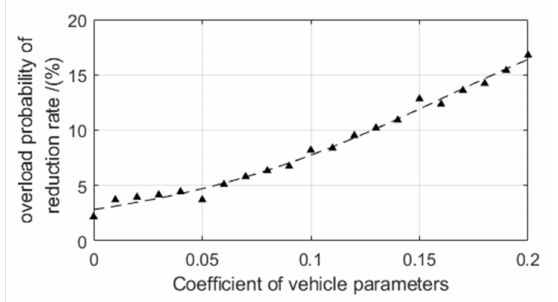
Figure 15. Overload probability of the reduction rate of wheel load for different variation coefficients.